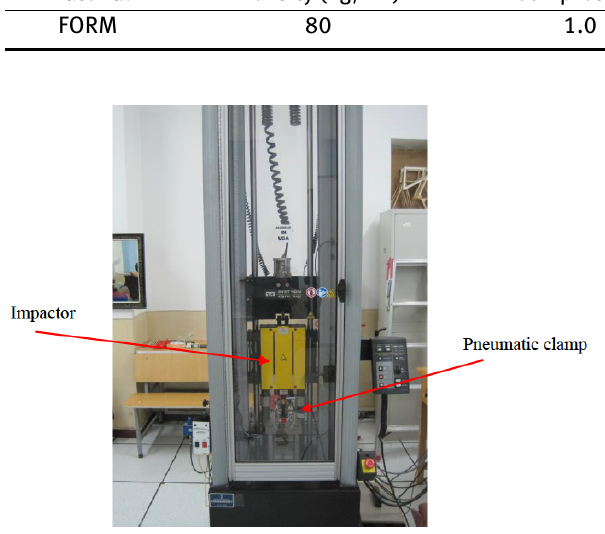
Figure 2: Drop-weight machine Instron